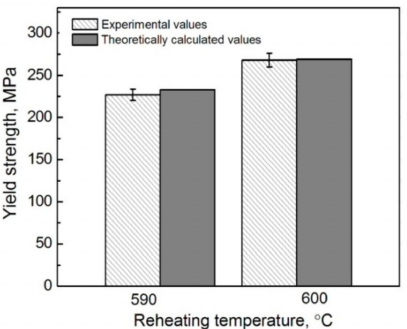
Figure 15. Experimental and theoretically calculated YS values of the Ti@(Al-Si-Ti) p /A356 composites thixoformed at reheating temperatures of 590 ◦ C and 600 ◦ C.